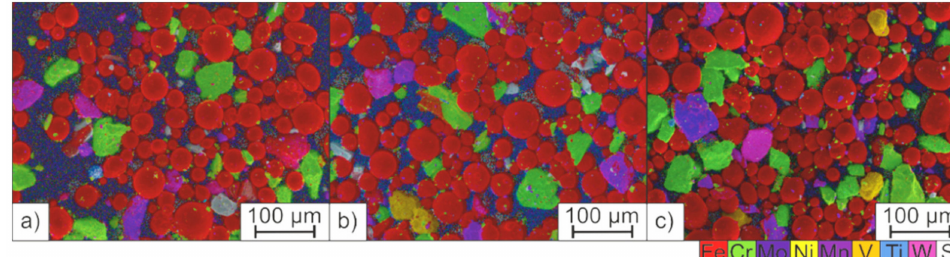
Figure 6. Qualitative EDS mappings of the H-MIX powder bed; ( a ) front, ( b ) centre, and ( c ) rear area of the build platform.